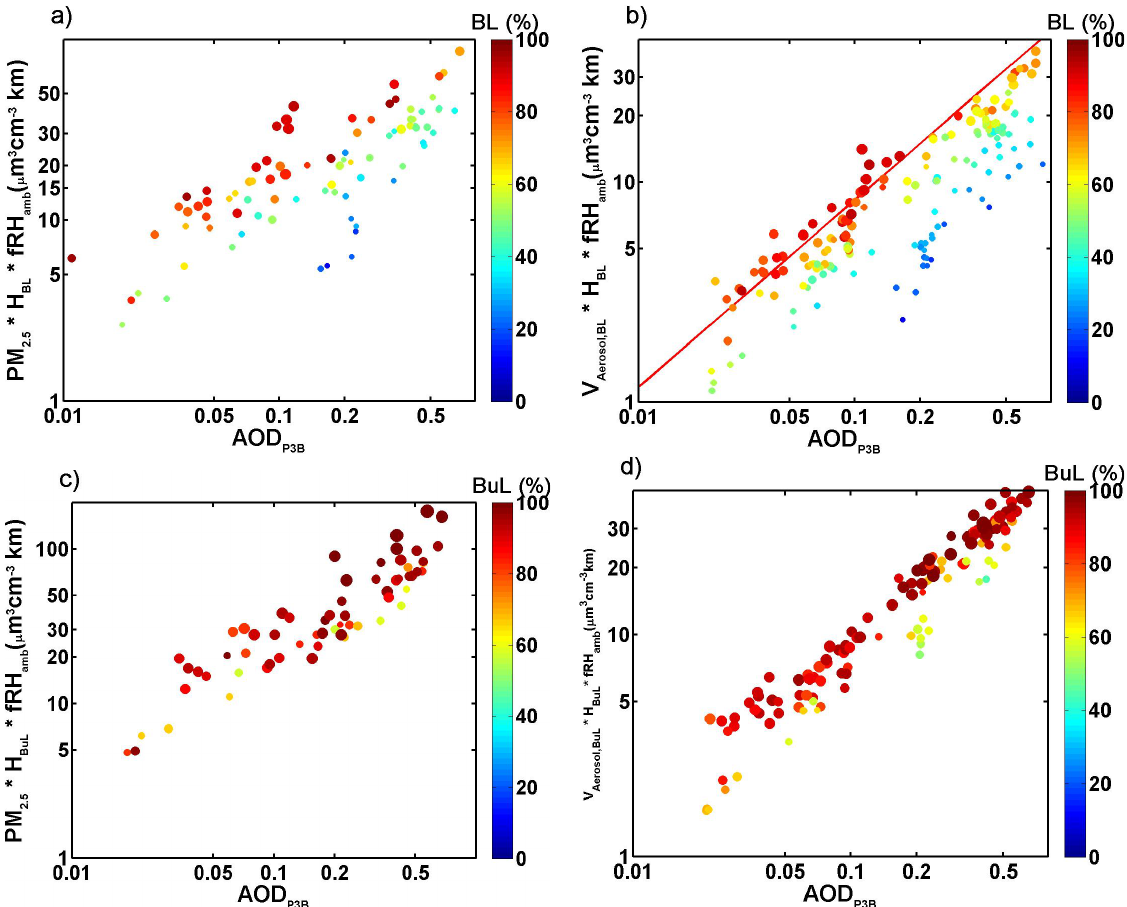
Fig. 7. PM 2 . 5 values weighted by varying factors as a function of the ambient AOD 550 nm measured by the P-3B. (a) uses the BL height and f (RH) amb , (b) uses the BL height and volume concentrations measured aboard the P3-B, (c) uses the BuL height and f (RH) amb , and (d) uses the BuL height and volume concentrations. The color code represents the BL (BL + BuL) contribution to the AOD and the size of each dot correspond to the BL (BuL) height ( (a) , (b) and (c) , (d) respectively). The red line is corresponding to the linear fit of cases where the AOD contribution of the BL is higher than